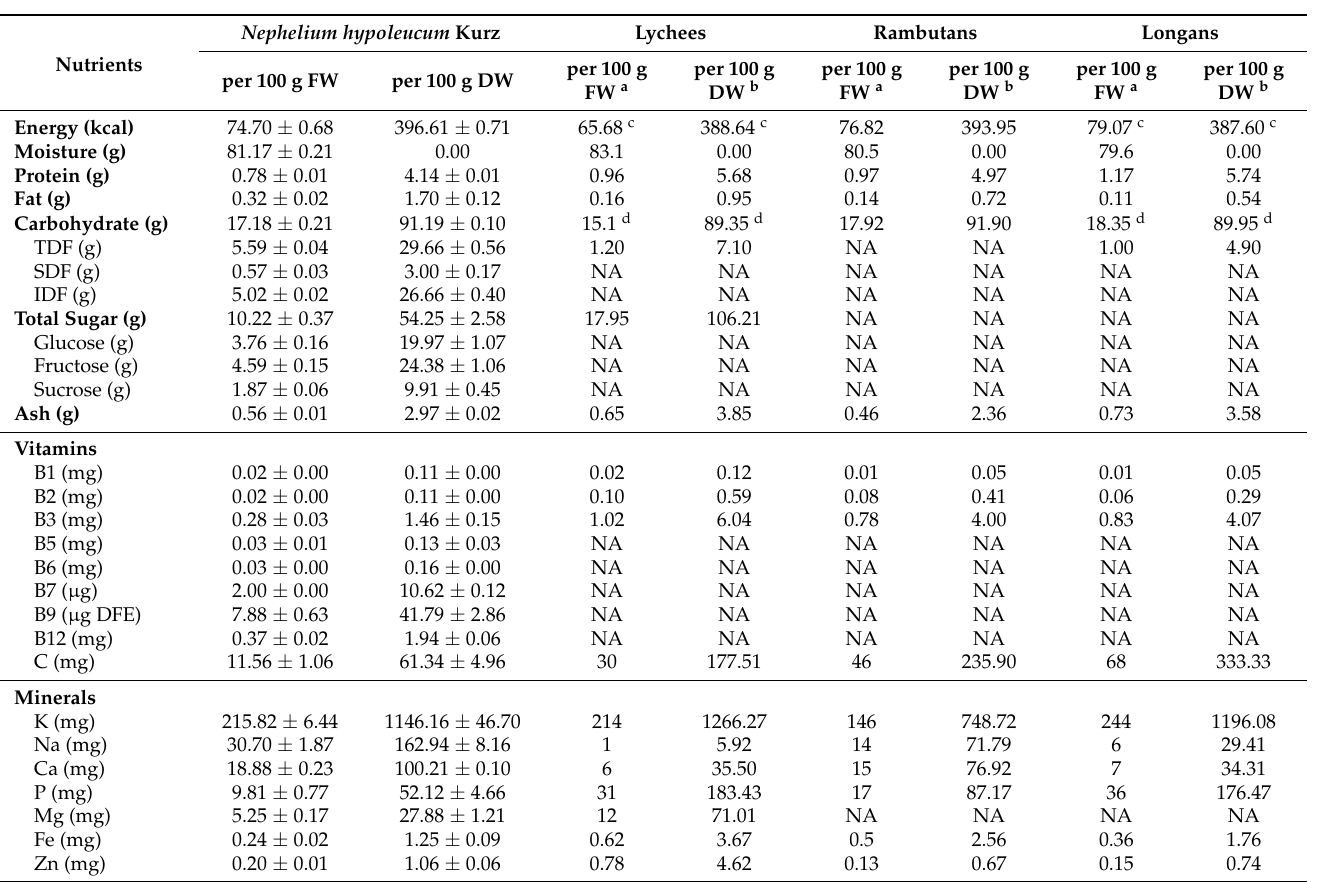
Table 2. Nutritional compositions of the aril part of Nephelium hypoleucum Kurz. compared to the reported literature on lychees ( Litchi chinensis S.), rambutans ( Nephelium lappaceum L.) and longans ( Dimocarpus longan